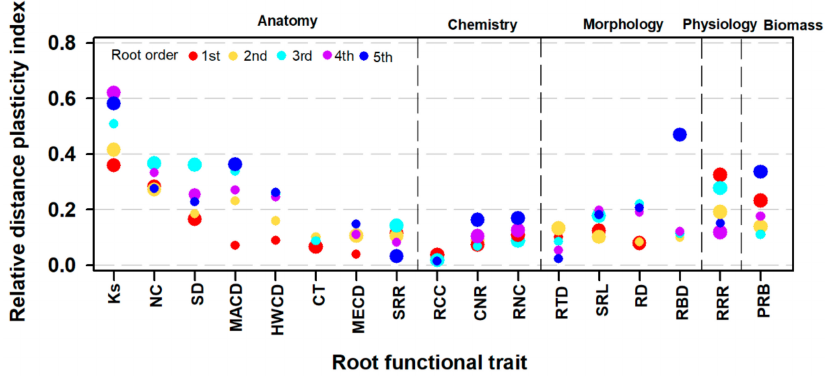
Figure 3. The relative distance plasticity index (RDPI) of root functional traits in response to soil depth in the first five root orders. Large points indicate that the averaged RDPI across the three species is significantly di ff erent from zero (no plasticity) according to a t -test ( p < 0.05), while small points indicate that the di ff erence is not significant ( p > 0.05). The trait abbreviations are as in Table 2.